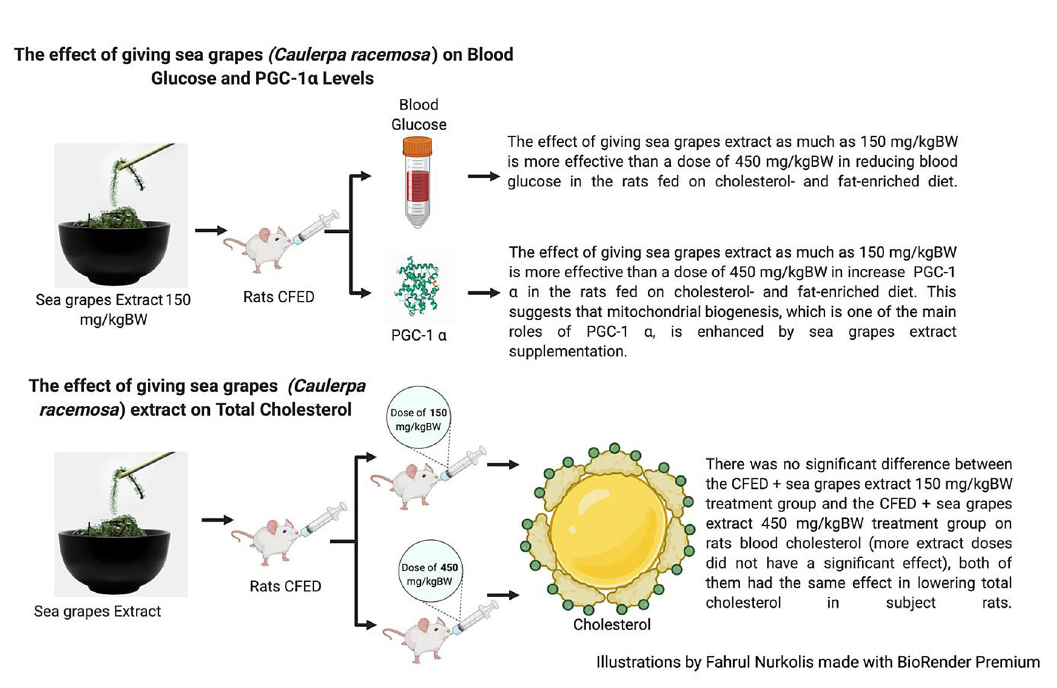
Figure 1. Effects of sea grapes extract on subject